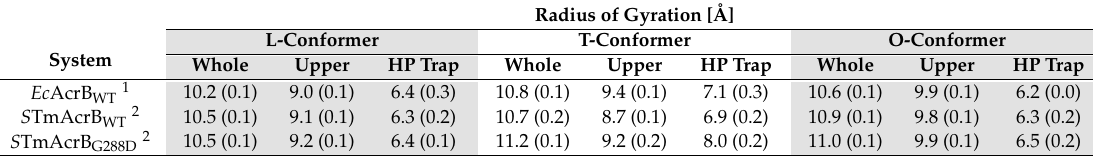
Table 3. Radius of gyration of the DBP calculated for every AcrB conformer. The three regions of the DBP considered in this calculation are indicated as Whole (entire DBP), Upper (upper part of the binding site), and HP trap (hydrophobic trap) (see Materials and Methods for the definition of these regions).